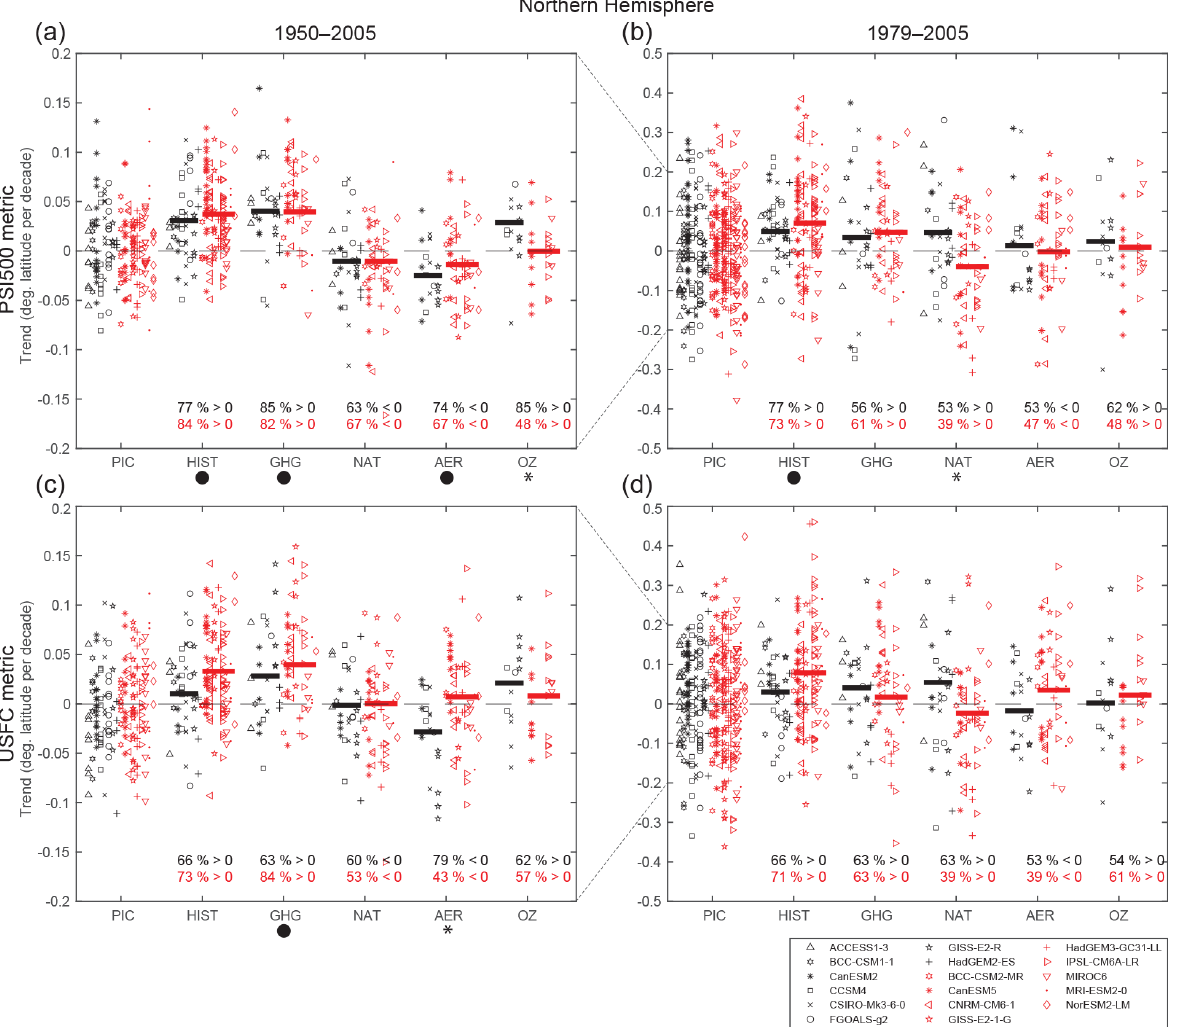
Figure 6. Trends in annual-mean NH Hadley cell edge latitude over (a, c) 1950–2005 and (b, d) 1979–2005 for (black) CMIP5 and (red) CMIP6 models. Trends are shown for all available ensemble members of the following runs: (HIST) historical, (GHG) greenhouse gas only, (NAT) solar and volcanic only, (AER) anthropogenic aerosol only, and (OZ) ozone only. Multi-model mean trends are shown as thick horizontal lines. Trends are also shown for all independent time periods of equivalent length from the pre-industrial control (PIC) runs. Large black dots denote forcings with trends statistically different from zero in both CMIP5 and CMIP6 models. Asterisks denote where multi-model means of CMIP5 and CMIP6 models are statistically different at the 95% confidence level via Student’s t